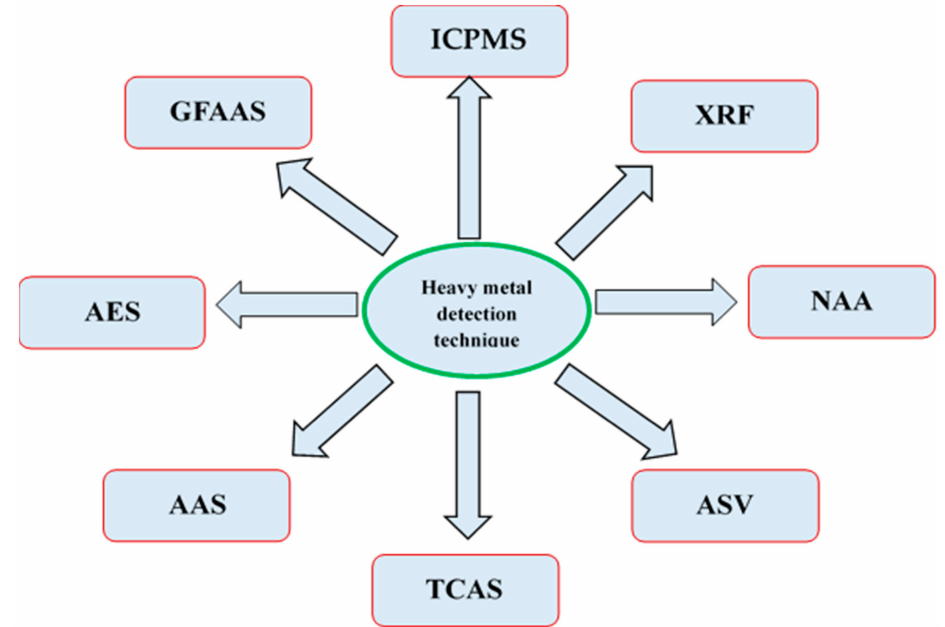
Figure 4. Techniques of heavy metal detection in herbal